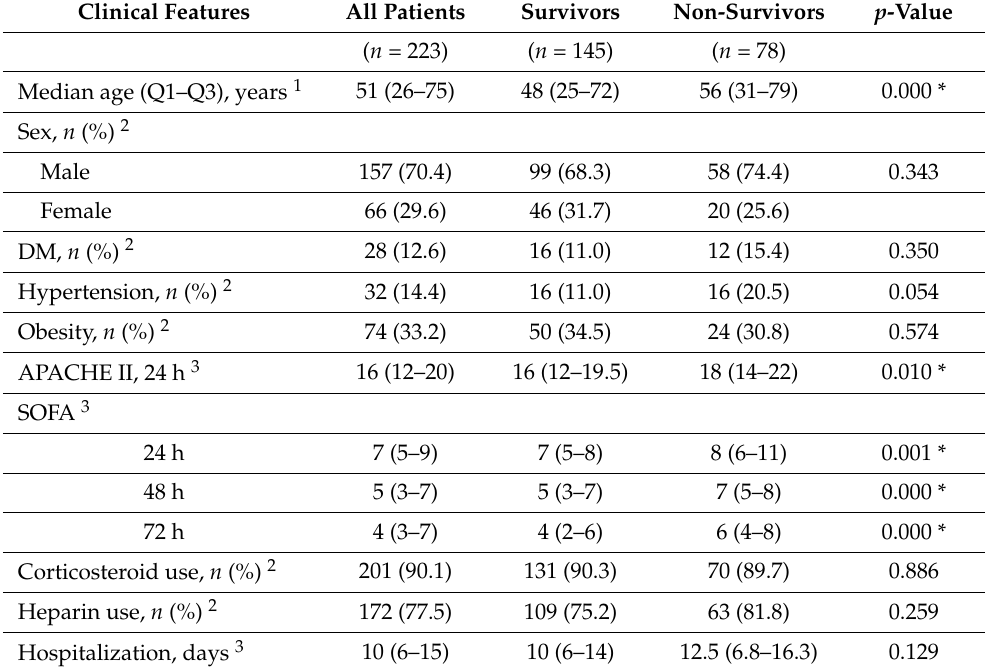
Table 1. Demographic and clinical characteristics in the overall population as well as in survivors and non-survivors in the intensive care unit. Data are expressed as medians (1st quartile (Q1)–3rd quartile (Q3)) or numbers (percentages). * Significant differences between survivors and non-survivors based on Student’s t -test 1 , Chi-square test, or Fisher’s exact statistic 2 and Mann–Whitney U test 3 . DM: diabetes mellitus; SOFA: sequential organ failure assessment; APACHE II: acute physiology and